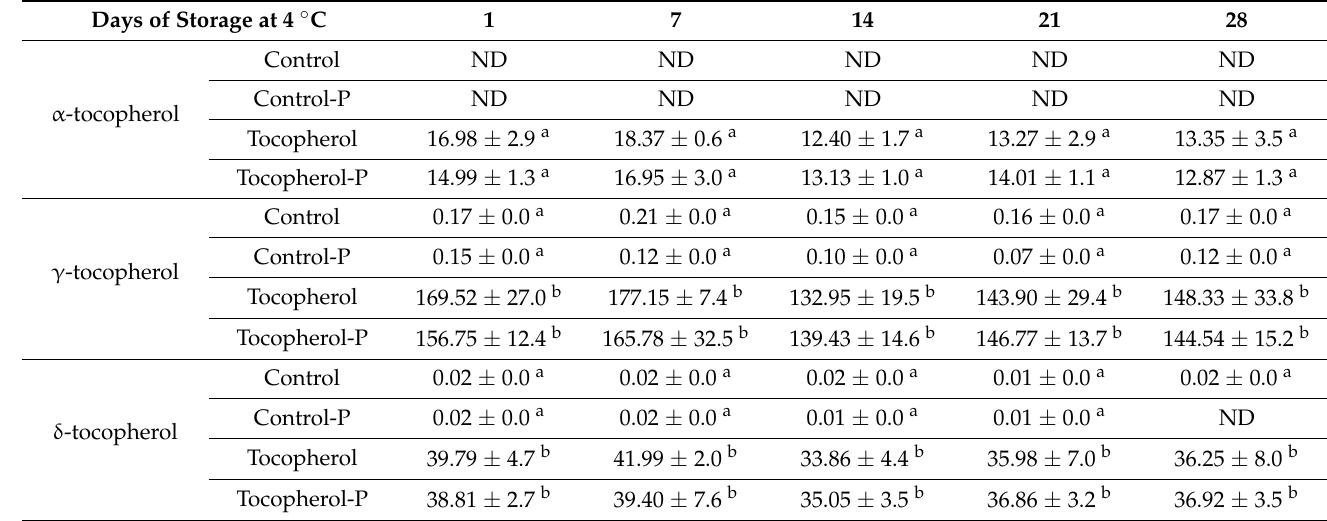
Table 1. Effect of pasteurization on tocopherol content ( µ g/mL) of the yogurt-based beverages during cold storage over a period of 28